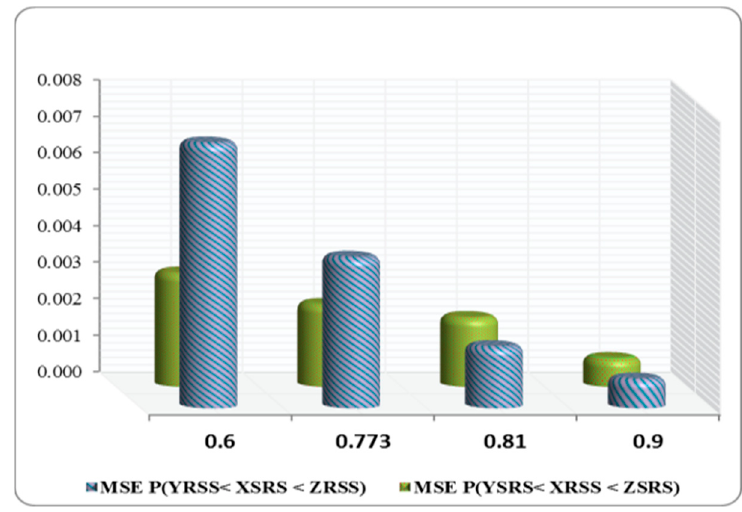
(cid:0) (cid:1) = ( ˆ R n 2 , n ∗ , n 3 4,20,4 ) at different values of R 3 and 4 for 1